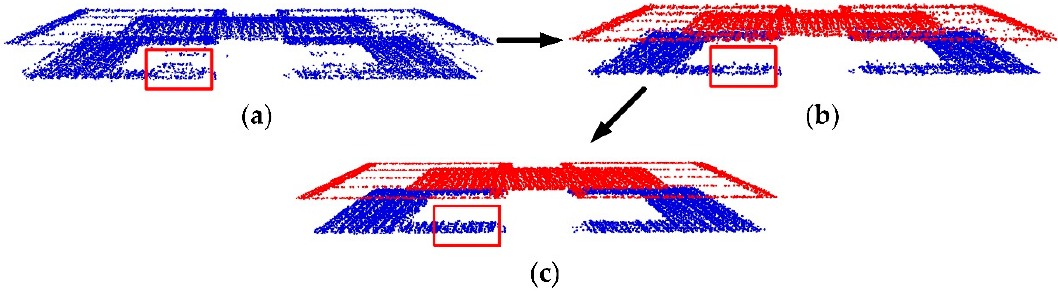
Figure 1. Smoothing of building rooftop points: ( a ) original points; ( b ) segmented points; and ( c ) smoothed points.